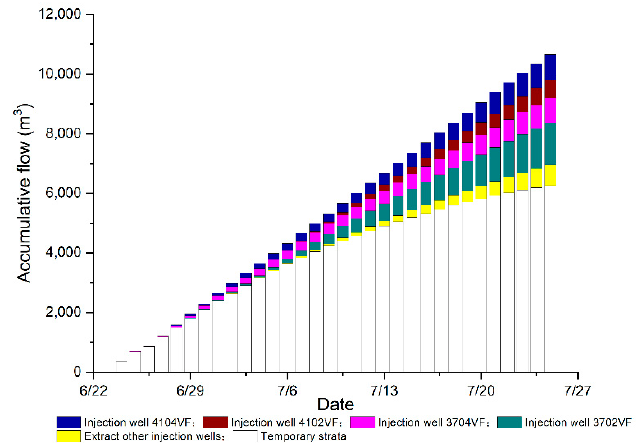
Figure 16. Solute composition analysis diagram of pumping well 3902.